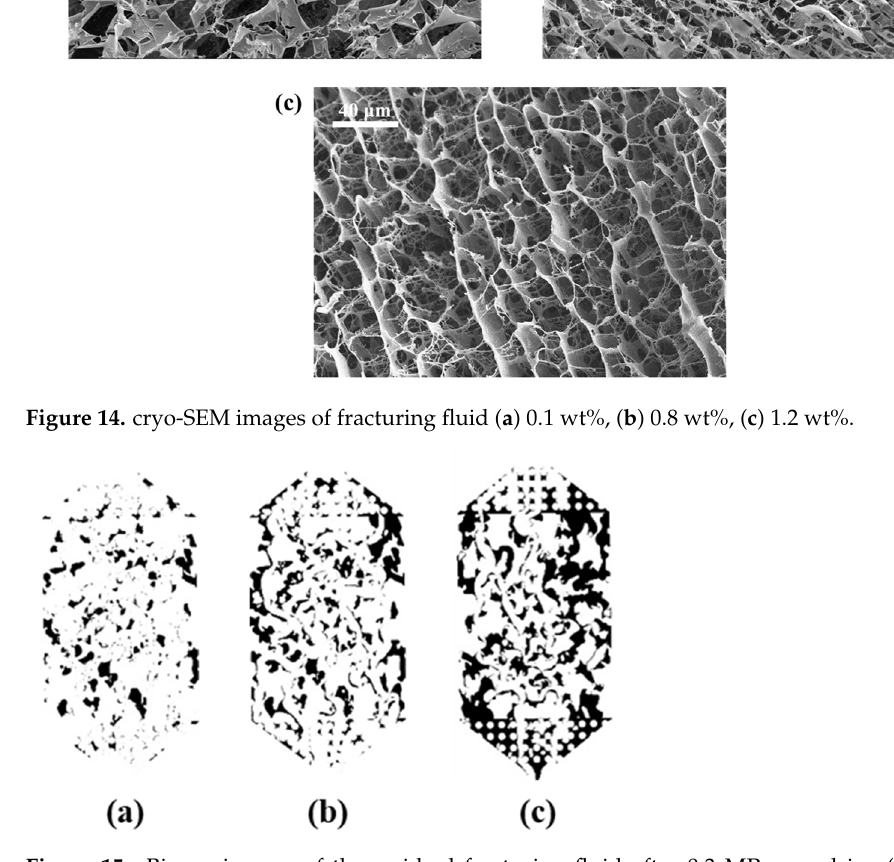
Figure 15. Binary images of the residual fracturing fluid after 0.3 MPa gas drive ( a ) 0.1 wt%, ( b ) 0.8 wt%, ( c ) 1.2 wt%.